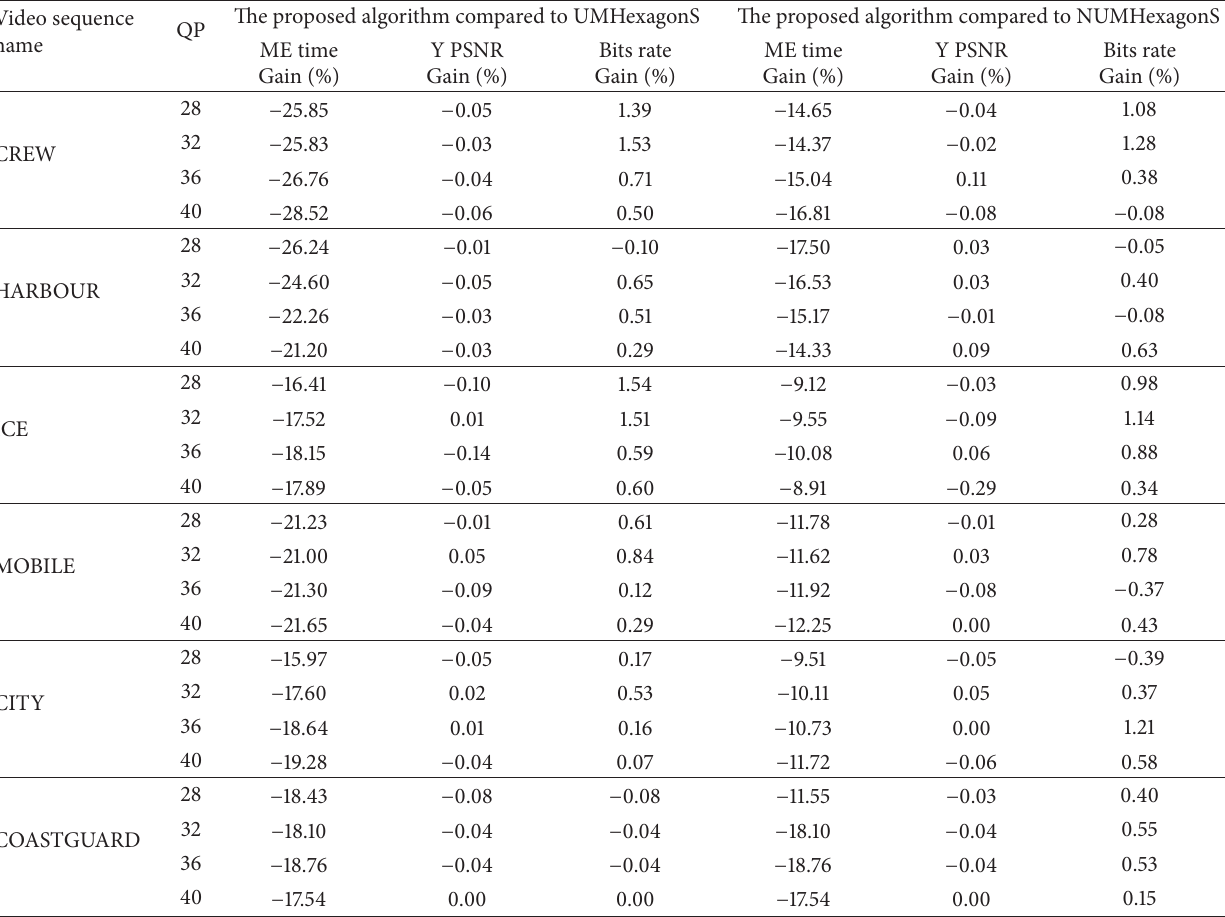
Table 4: Performance of the proposed algorithm